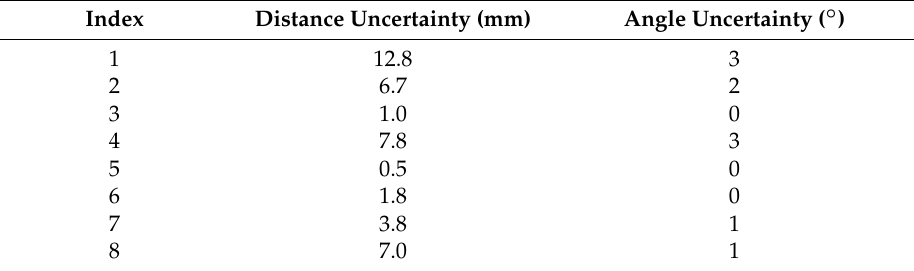
Table 5. Accuracy of the mapping